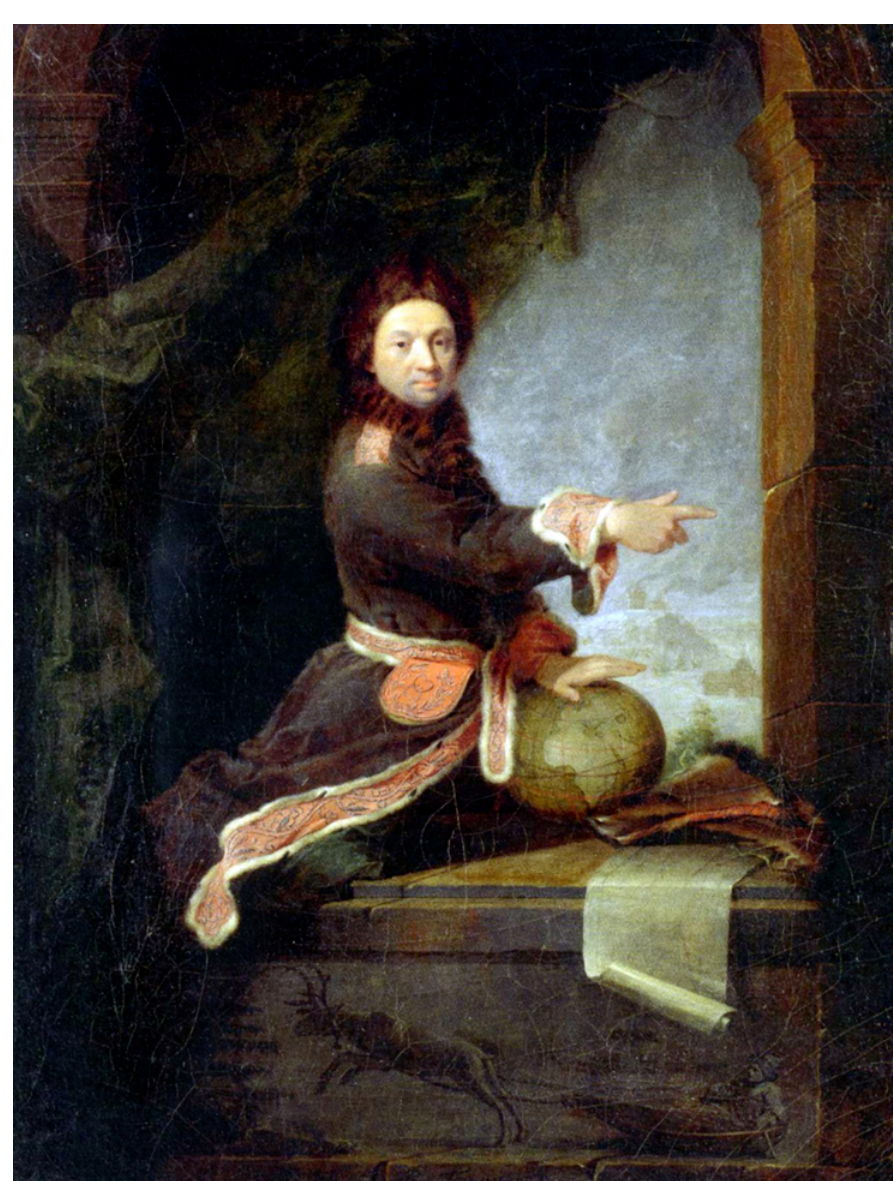
Figure 1 Robert Tournières: Pierre-Louis Moreau de Maupertuis (1740). Stiftung Preußische Schlösser und Gärten, GK I 10166. Licence: CC-0. Source: